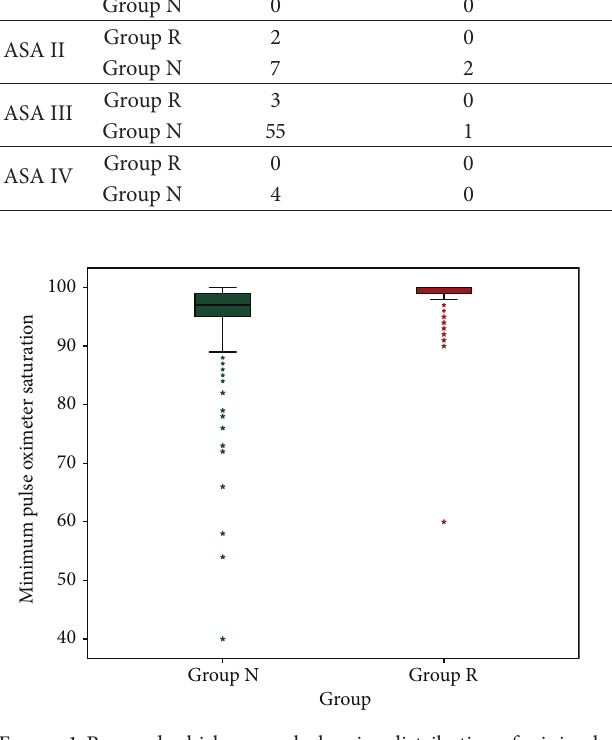
Figure 1: Box-and-whiskers graph showing distribution of minimal oxygen saturation (whiskers show 95 percentile range) in both groups. The stars represent outliers in both groups.